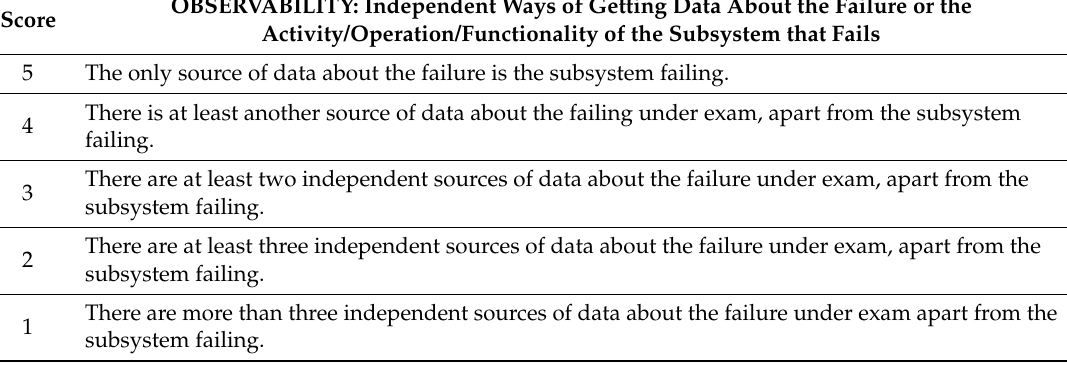
Table 7. Observability